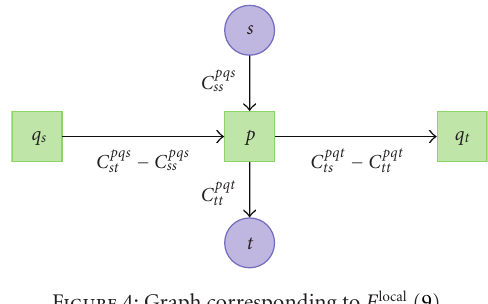
Figure 4: Graph corresponding to E local